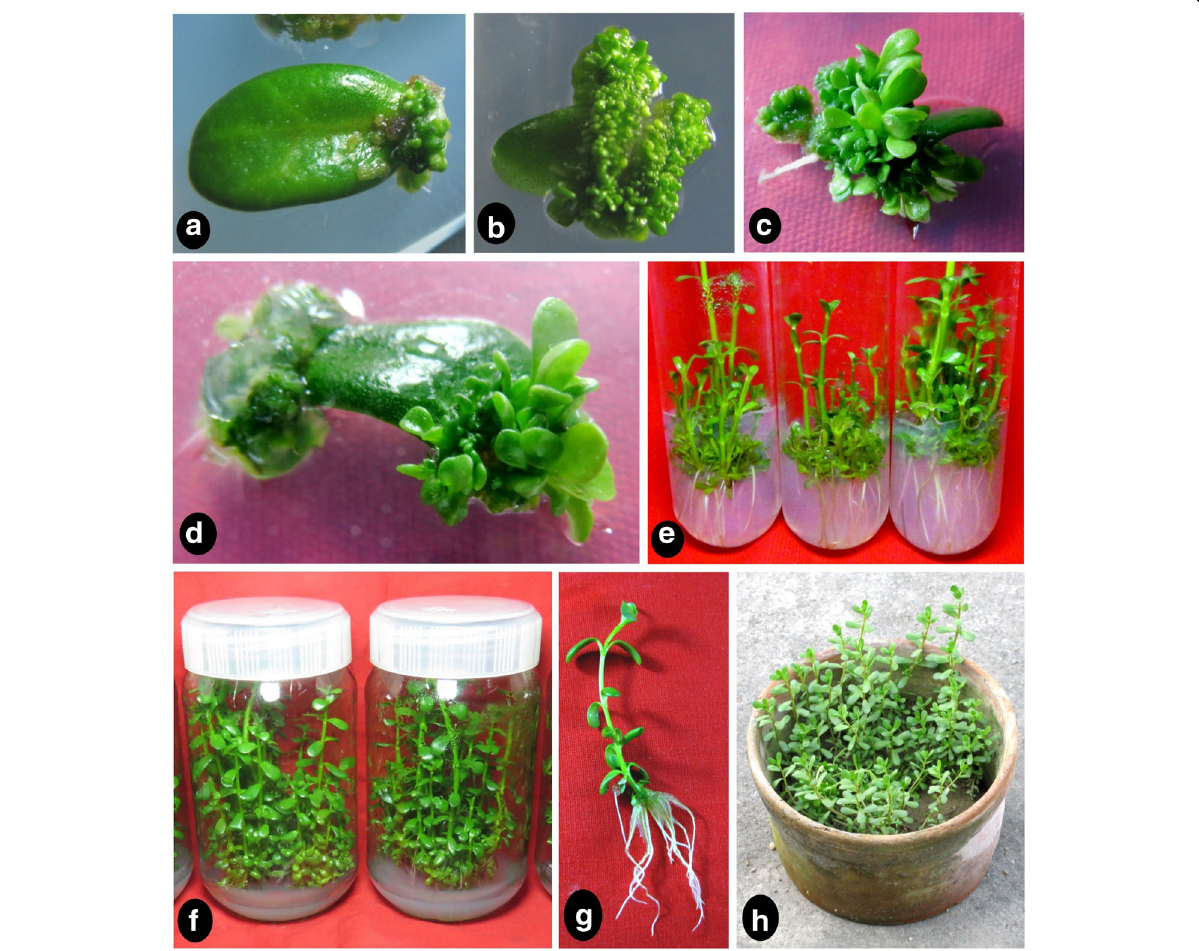
Fig. 1 Different stages of micropropagation of Bacopa monnieri. a Induction of shoot buds from the cut edges of leaf after 8 days of inoculation in medium containing 0.5 mg/L KIN. b Shoot buds induced in medium containing 1.5 mg/L BAP after 12 days of inoculation. c & d Shoot buds start to elongate in medium containing 1.5 mg/L BAP and 2.0 mM spermidine after 21 days of inoculation. e Elongated shoots after 42 days of inoculation. f Plants grown in half strength MS medium without any PGR. g A complete plantlets with well developed root system ready for field transfer. h Tissue culture derived ex vitro field grown micropropagated